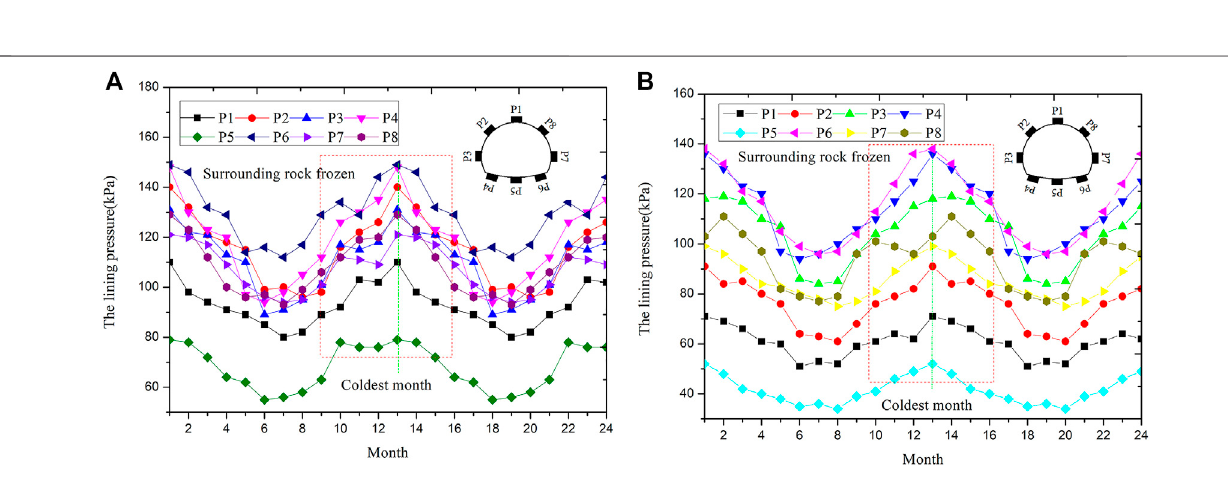
FIGURE 4 | The lining pressure. (A) Section 700 (B) Section